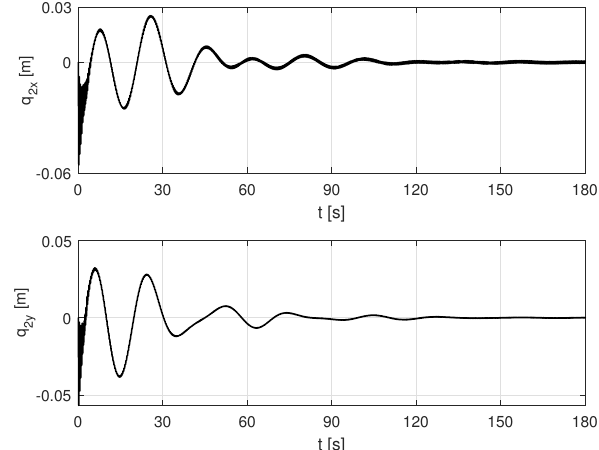
Figure 11. Displacement of appendage